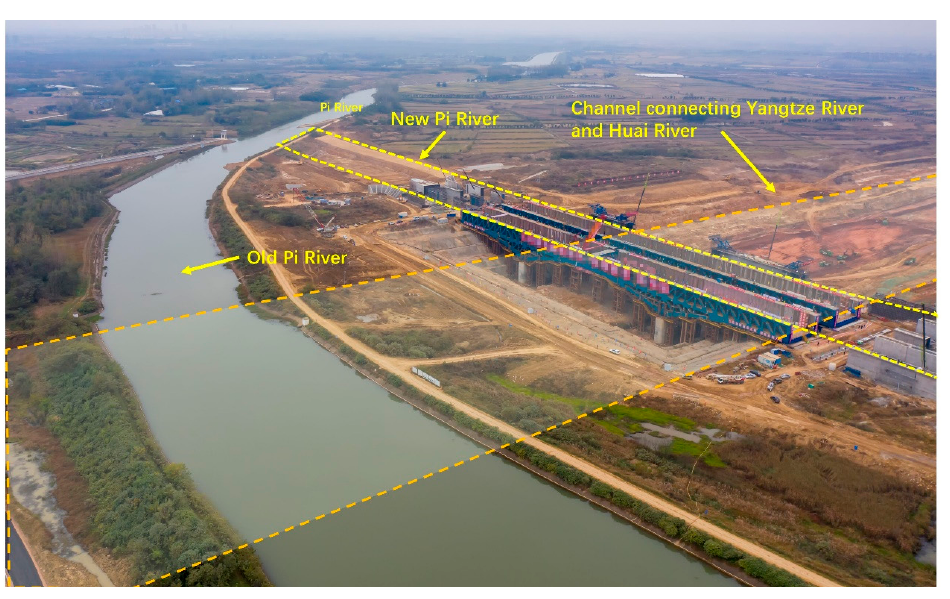
Figure 2. Front elevation of the aqueduct. The cross-section of the mid-span of the aqueduct is shown in Figure 3. The cross- section is 9 m high and 23 m wide. The check water level is 5.05 m, and the design water level is 4.0 m.